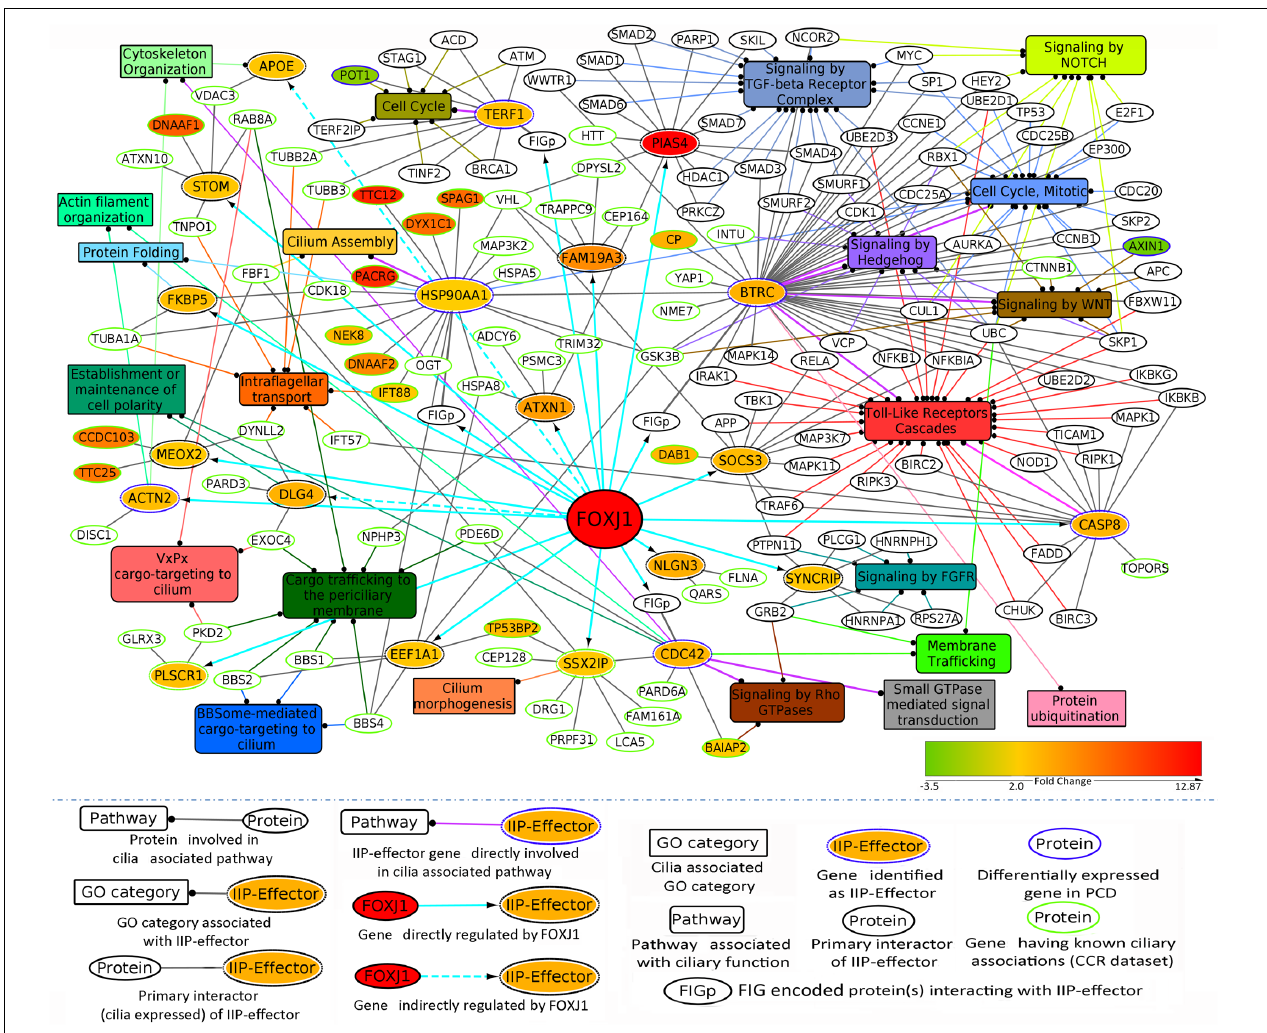
FIGURE 4 | IIP-effectors in FOXJ1 regulatory network and their probable ciliary associations. Probable cilia associated pathways or processes that the IIP-effectors and their network interactors may participate in were determined with the help of pathway enrichment and GO analysis and such possible ciliary role(s) of each IIP-effector is depicted. The edge color denotes the ciliary process(es) or pathway(s) the gene/protein is/are associated with. Fold changes in genes differentially expressed in Choksi et al. expression study (Choksi et al., 2014a) or PCD case study (Geremek et al., 2014) are mapped onto the protein nodes.